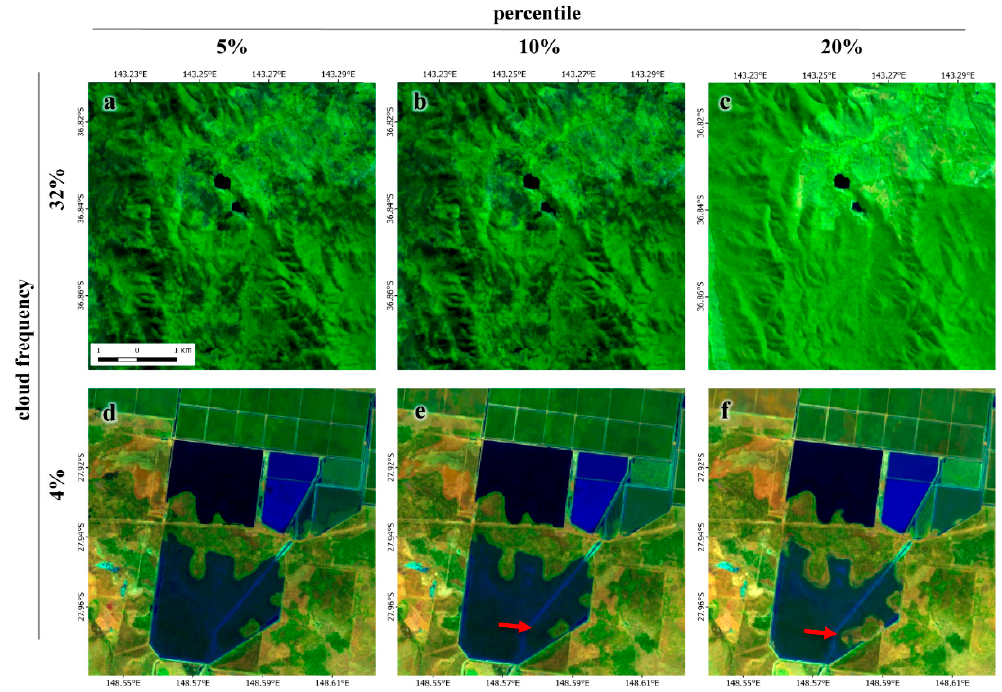
Figure 6. Intensity percentile (5%, 10%, 20%) false-color images (SWIR1, NIR, green) for areas with an average cloud cover of 32% ( a – c ) and 4% ( d – f ).